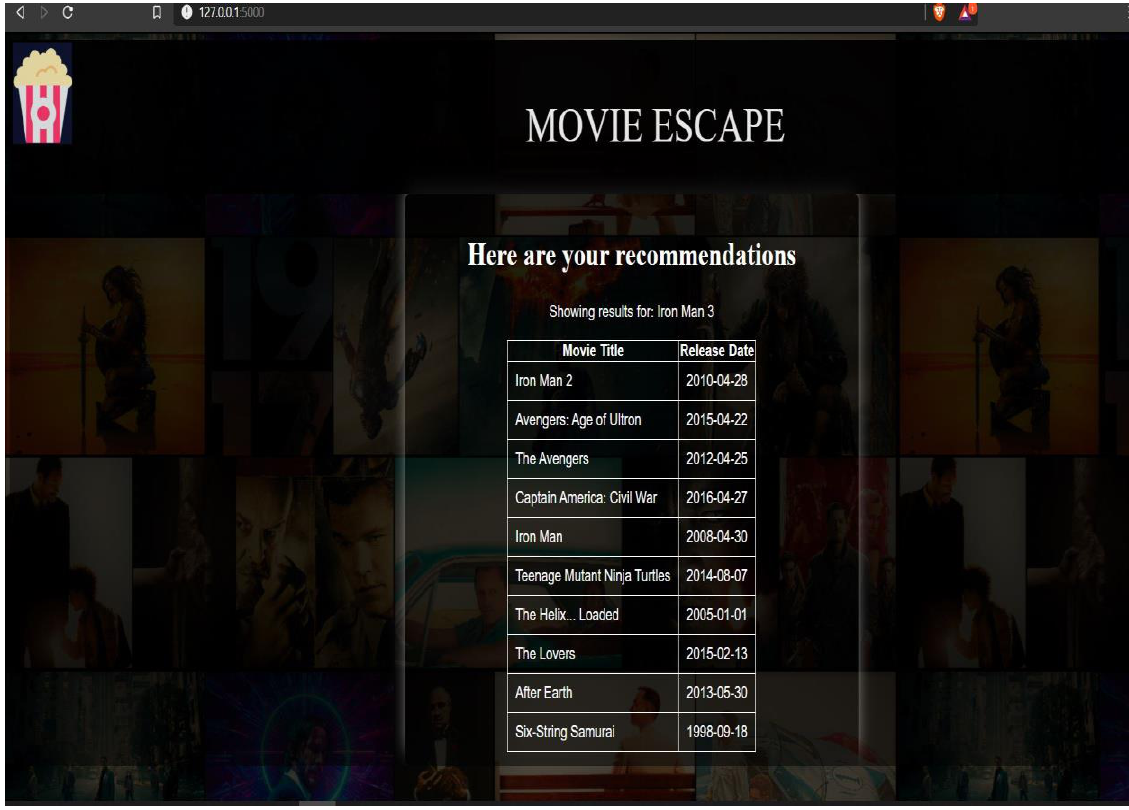
Figure 2. Home page of our proposed movie recommendation system with user input option.